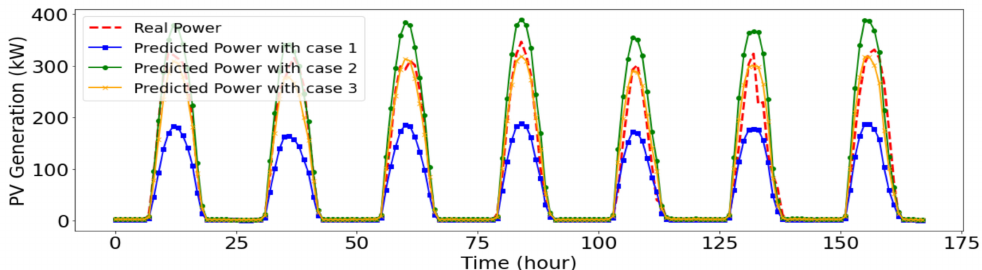
Figure 11. Regional PV generation forecasting results.